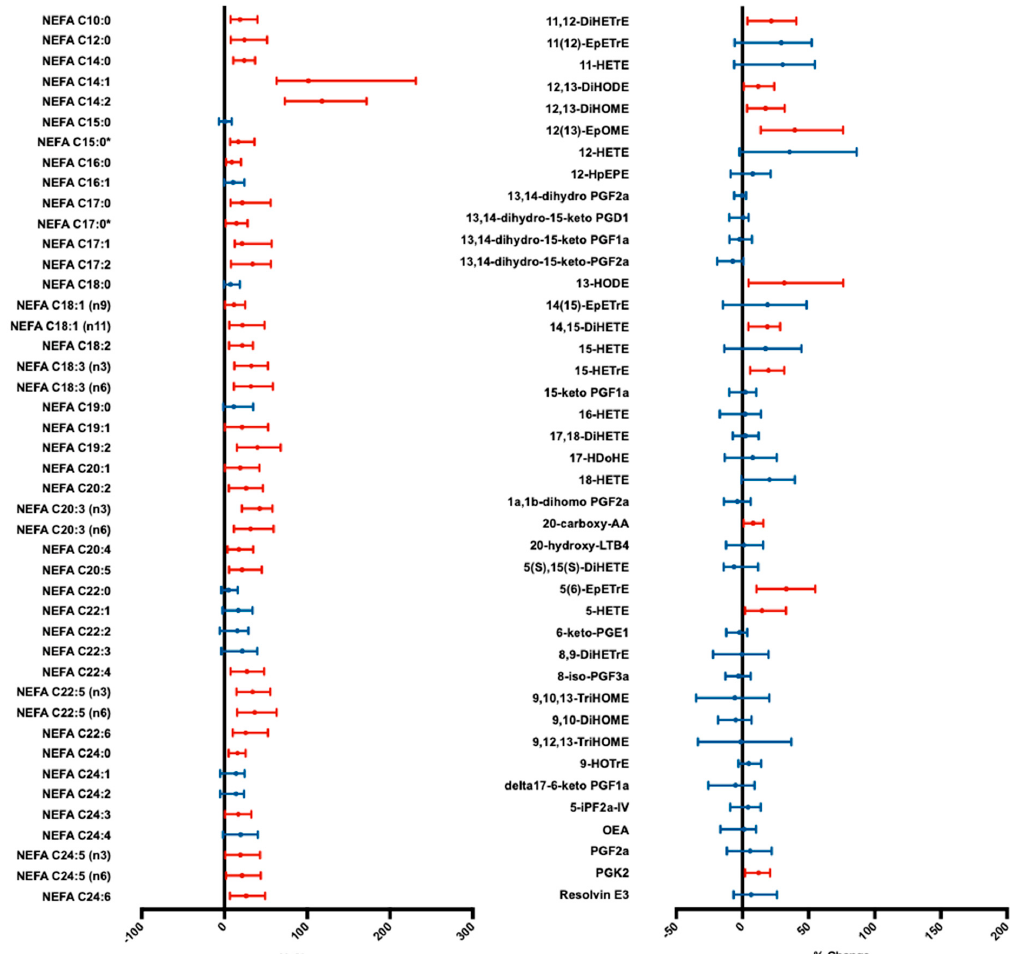
Figure 2. Forest plot of median non-esterified fatty acid (NEFA; left panel) and oxylipin (right panel) species plasma concentration change during cold exposure. Error bars indicate 95% confidence intervals. p values calculated using a Wilcoxon signed-rank test ( n = 14). Significant changes ( p < 0.05) shown in red; statistically insignificant changes shown in blue. * Indicates branched isomers.